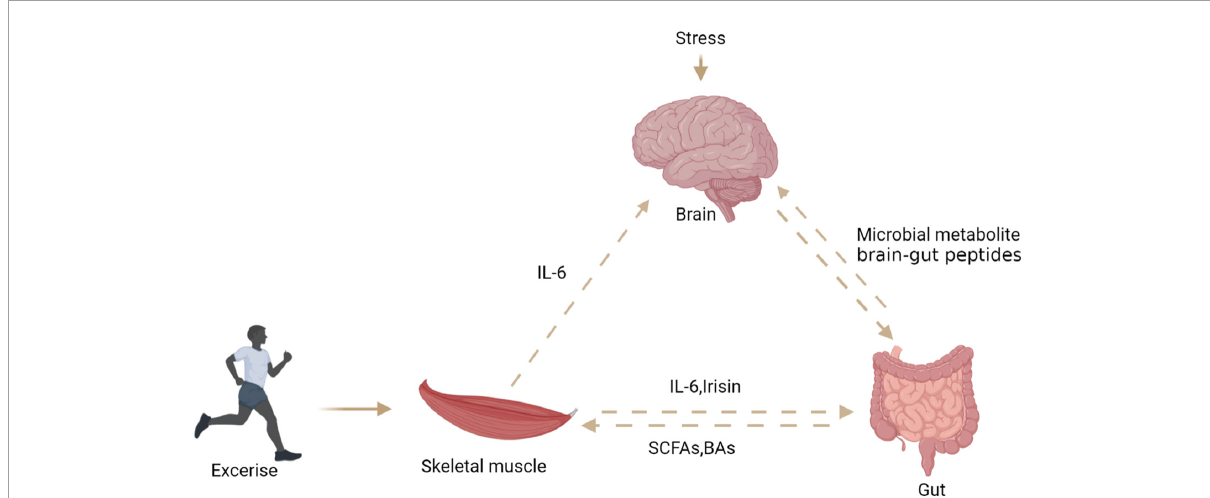
FIGURE7 The relationship between brain, gut, and skeletal muscle. Exercise can stimulate skeletal muscle to secrete interleukin-6 and irisin, which act on intestinal endocrine cells to secrete PYY, stimulate the central system and affect appetite. Stress stimulates the central system to affect the intestinal barrier through the HPA axis. Intestinal microbial metabolites can directly or indirectly affect the central system activity and skeletal muscle energy